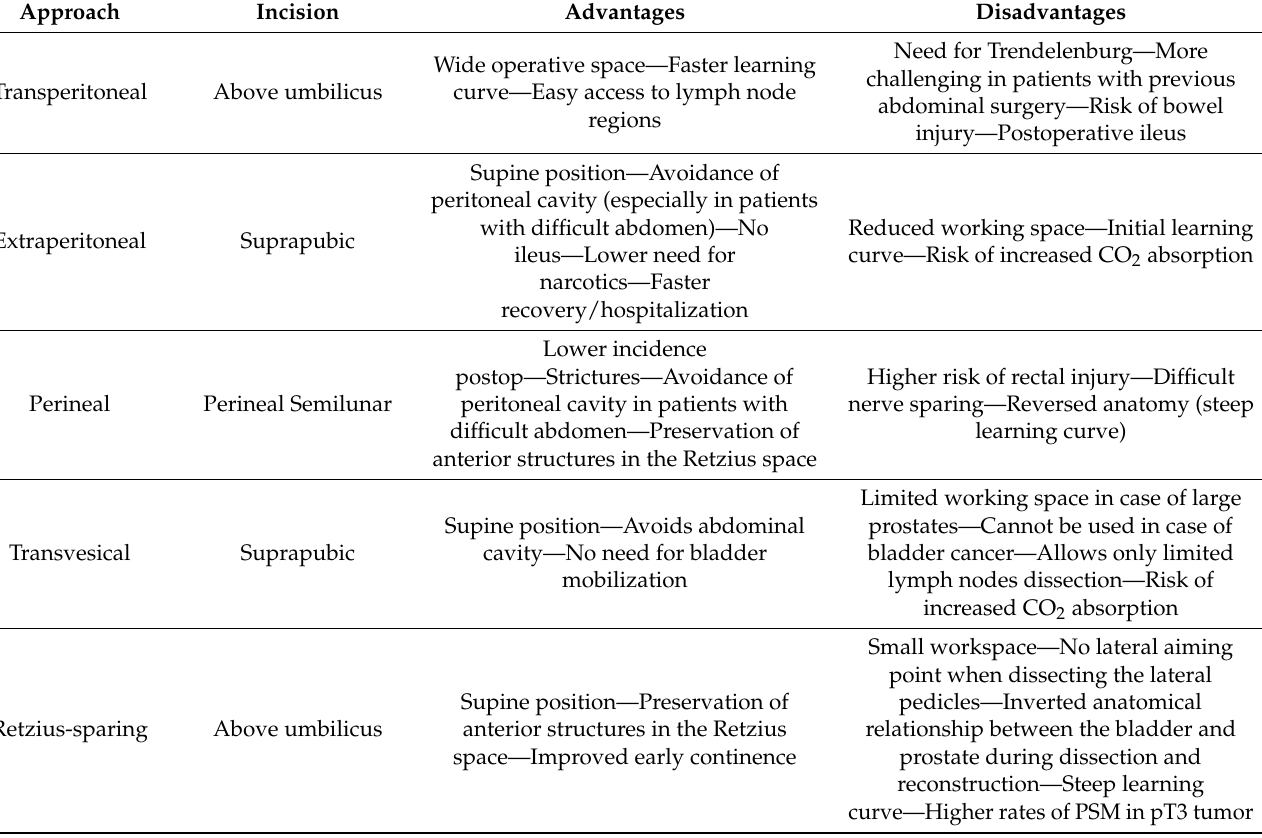
Table 1. Different SP approaches for RALP procedure: advantages and